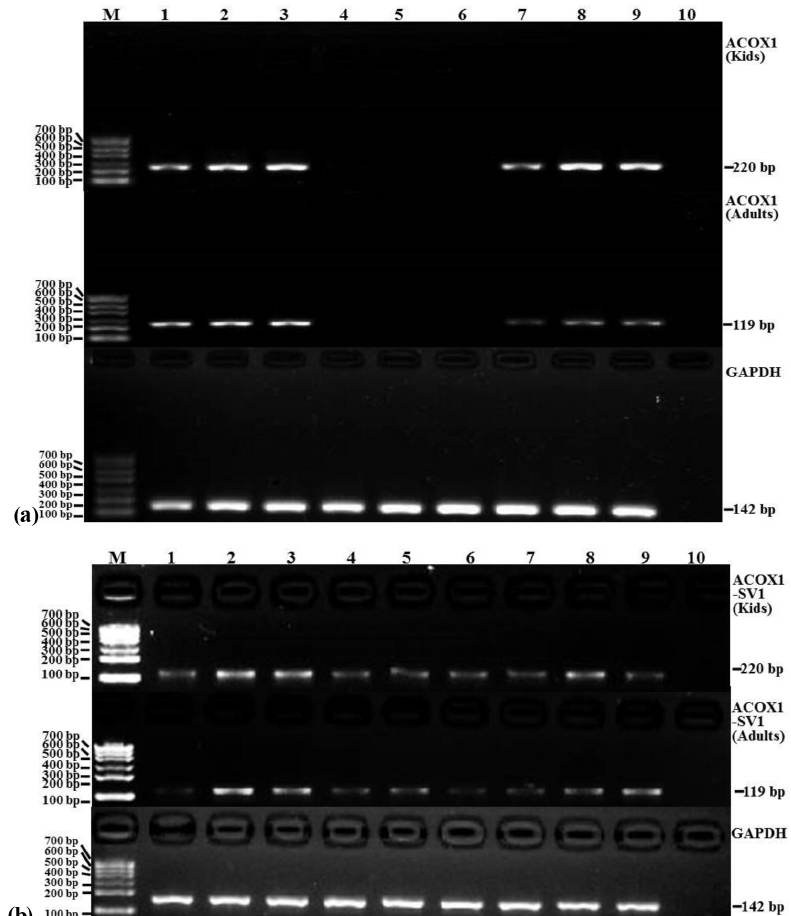
Figure 5. The mRNA expression patterns of ACOX1 (a) , ACOX1-SV1 (b) and GAPDH from various tissue types in the groups of kids and adults. Note: lanes (Ln) 1 – heart; Ln 2 – liver; Ln 3 – spleen; Ln 4 – lung; Ln 5 – kidney; Ln 6 – leg muscle; Ln 7 – longissimus muscle; Ln 8 – adipose; Ln 9 – brain; Ln 10 – NTC. Marker: marker